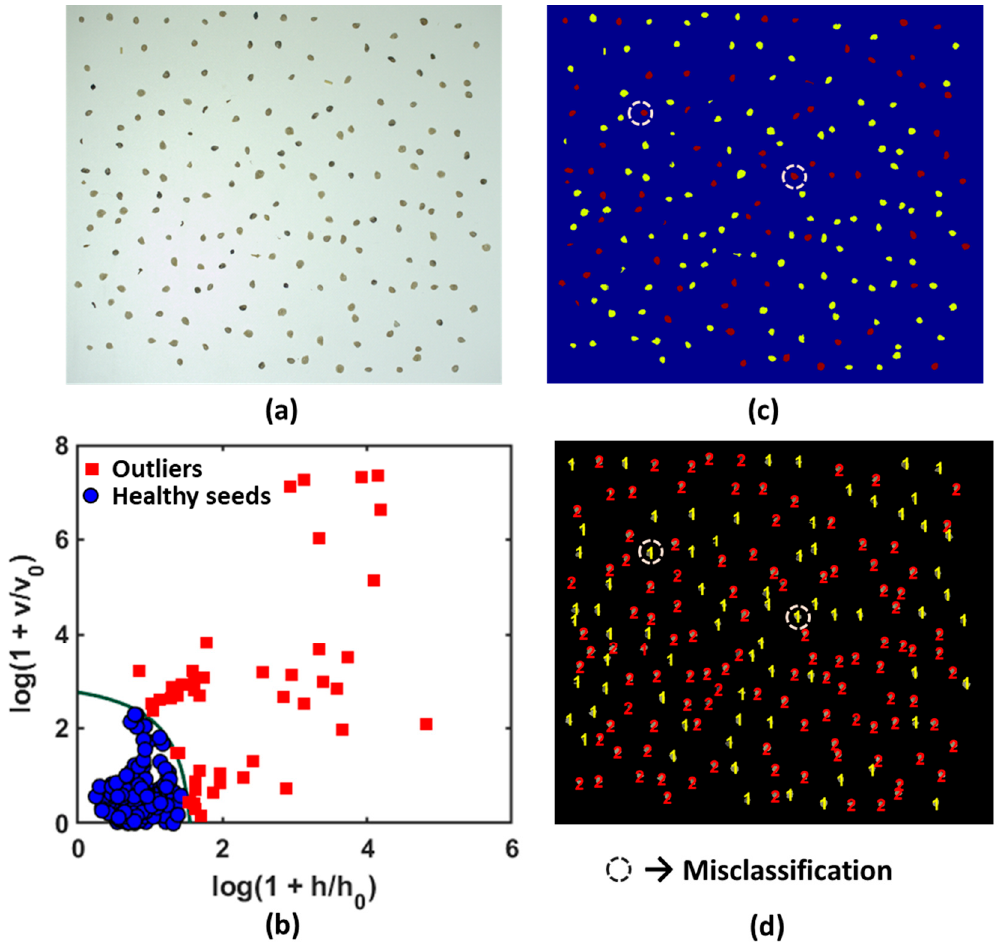
Figure 8. Test set classification with the developed model. ( a ) Original mixed samples; ( b ) Model application on test set; ( c ) Color coded samples; ( d ) Two groups were application on test set; ( c ) Color coded samples; ( d ) Two groups were identified.